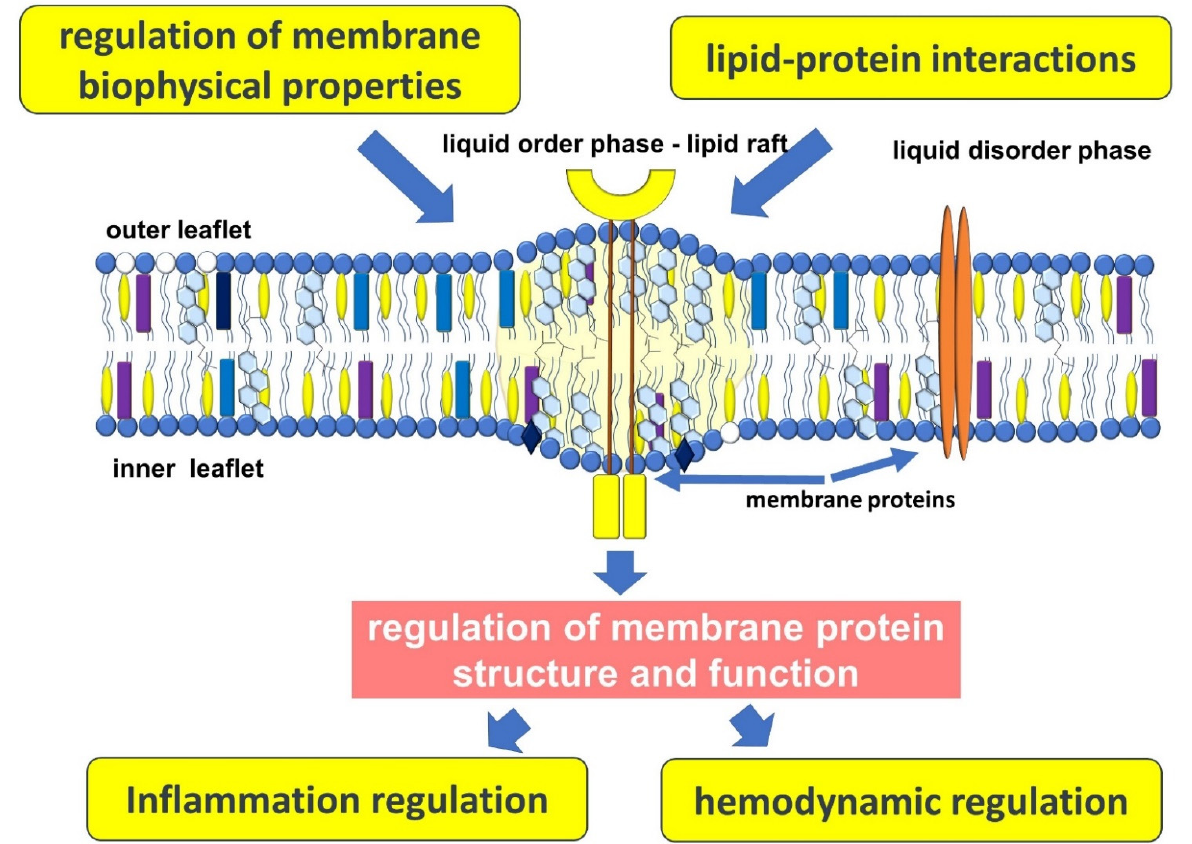
Figure 2. Plasma membrane function in atherogenesis.